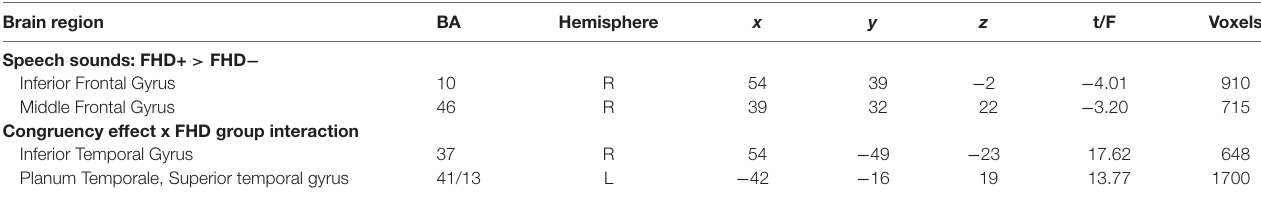
Note: The results are reported at voxel-wise threshold of p < 0.01, corrected for multiple comparisons using cluster extent threshold of p <